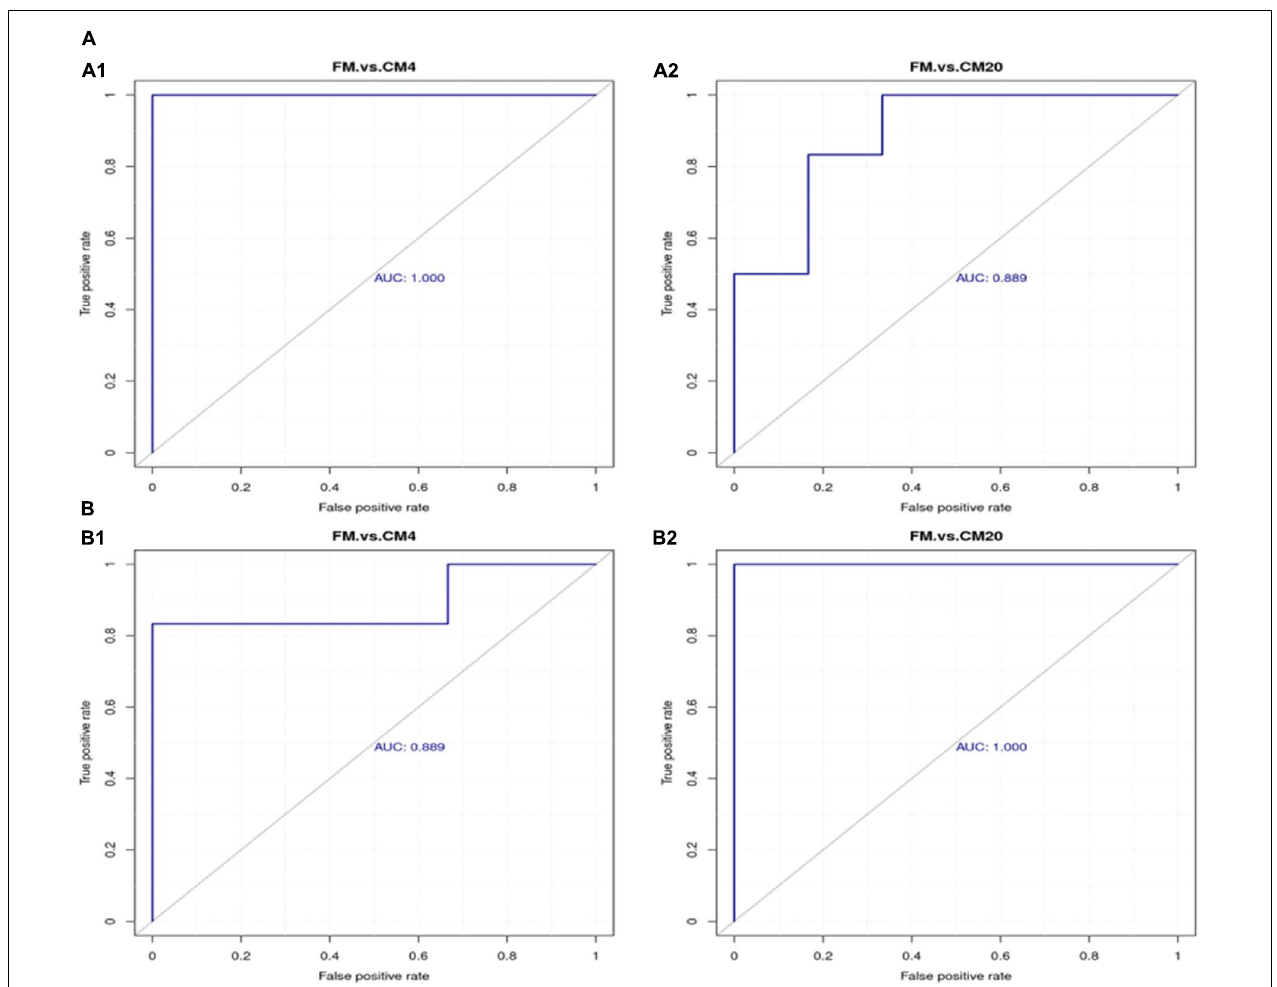
FIGURE 11 | The ROC curve analysis for differentiating among groups with respect to the potential biomarker metabolites in the positive (A1,A2) and negative (B1,B2) modes. Abbreviations are as defined in Figure 1 . n =